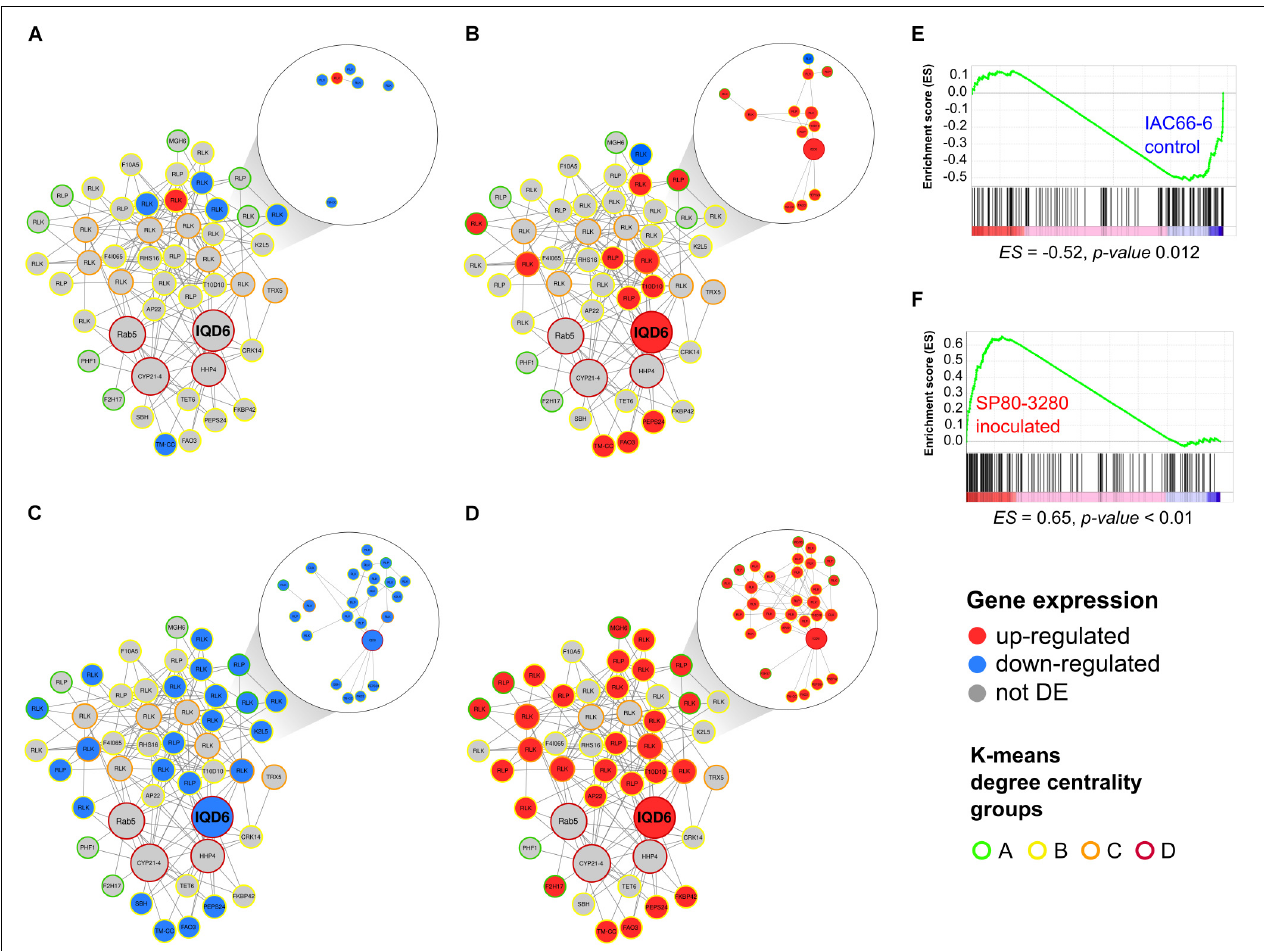
FIGURE 3 | Graph overview of core-periphery MCODE module 42 (48 nodes and 166 edges) alongside the expression profiles of genes within nodes from two sugarcane transcriptome experiments of IAC66-6 and SP80-3280. (A) IAC DEGs, (B) SP DEGs, (C) IAC GSEA leading-edge genes, (D) SP GSEA leading-edge genes. Node sizes represent centrality degree values. Node expression profiles are colored according to the legend, standing for not differentially expressed (DE), upregulated or downregulated, relative to sugarcane orthologs with the lowest p -value of each node in the two sugarcane transcriptome experiments. Node edges are colored according to the legend of the K -means degree centrality groups. Edges connecting DE nodes were also colored as gray, red, or blue, indicating the expression profile pattern of the node. GSEA signatures of IAC and SP in (E) and (F) , respectively, show the module 42 gene set